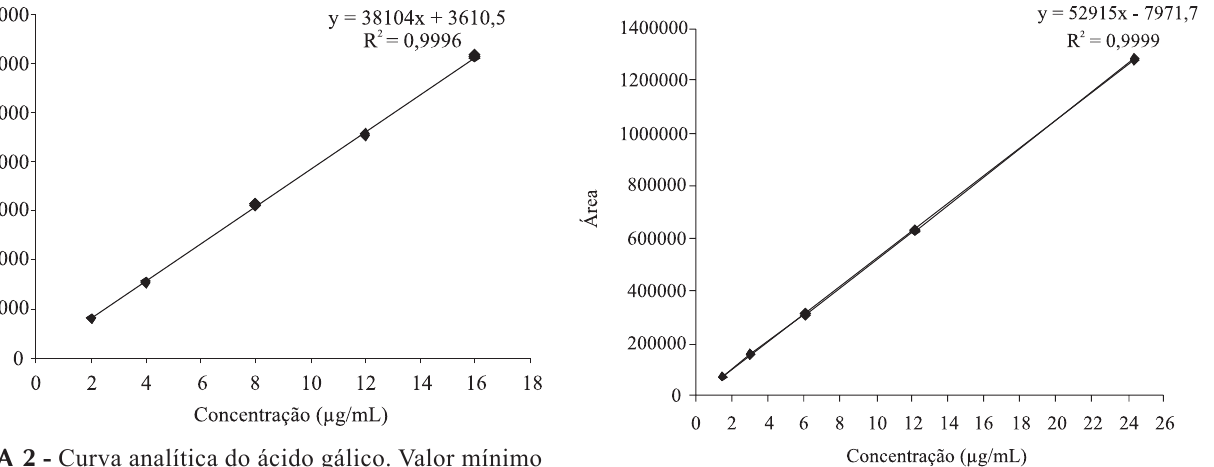
FIGURA 2 - Curva analítica do ácido gálico. Valor mínimo do coeficiente de correlação (“R 2” ) estipulado pela RE nº 899: 0,9900.